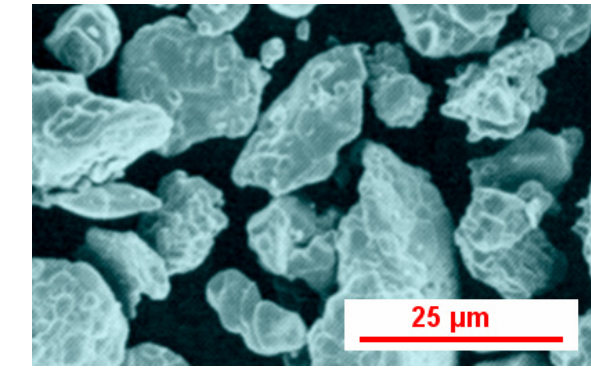
Figure 1 – (SEM) surface shape of Mo&O 2 powder particles Рис . 1 – (SEM) Изображение поверхности частиц порошка Mo&O 2 Слика 1 – (SEM) Облик површине честица праха Mo&O